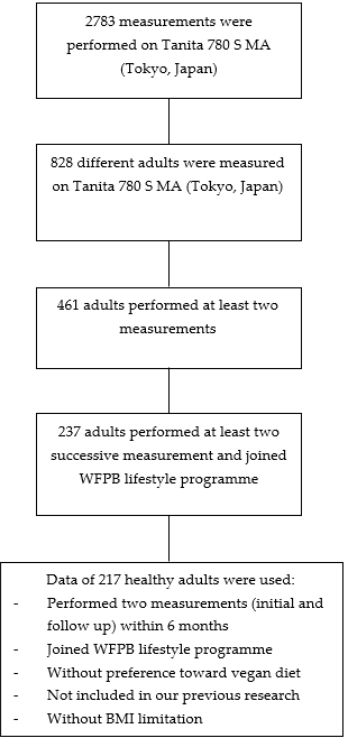
Figure 1. The flow of the analysed data.